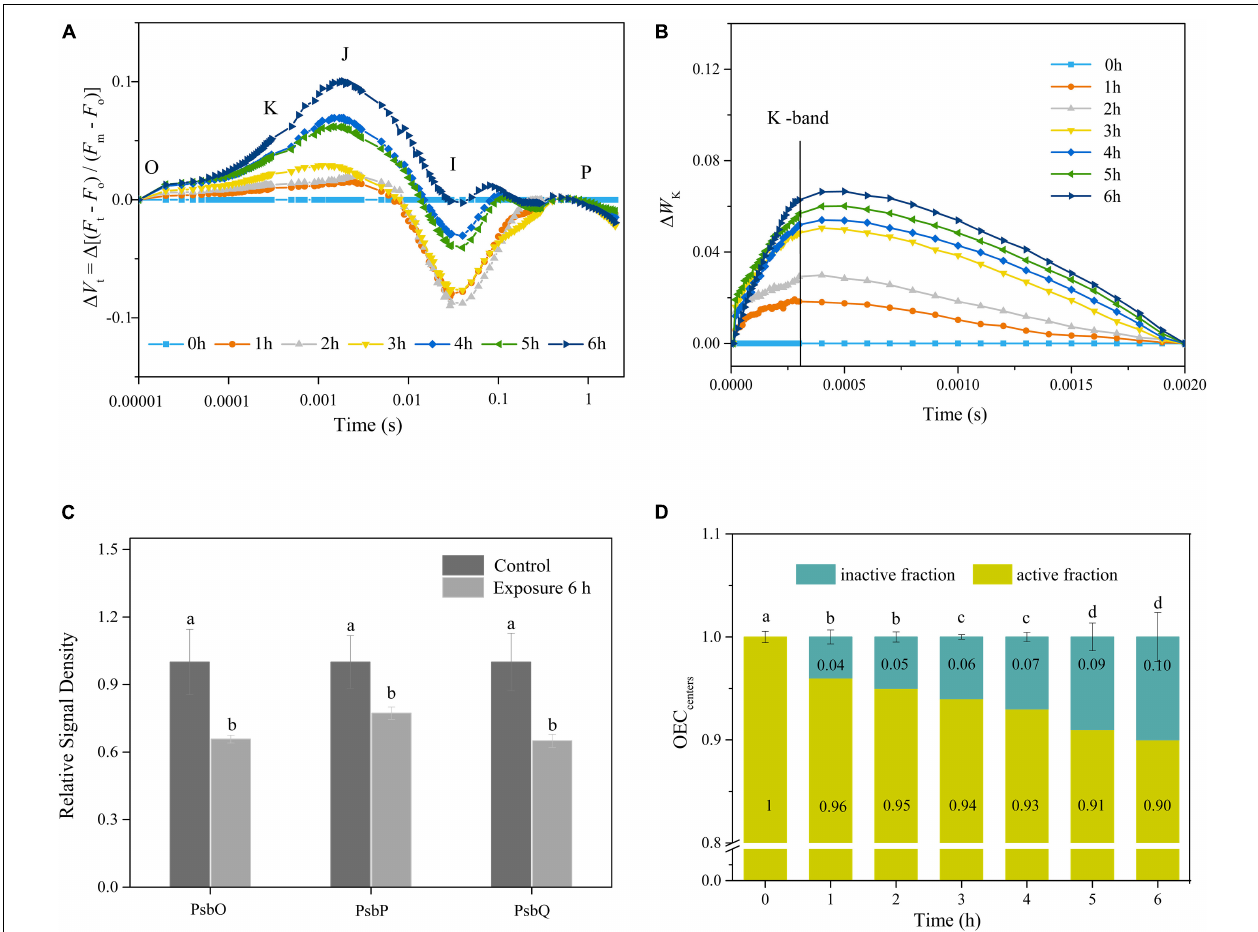
FIGURE 2 | (A,B) Time courses of normalized chlorophyll a fluorescence intensity of (cid:49) V t and (cid:49) W K curves in response to HL (400 µ mol photons/m 2 s) exposure. Each curve represents the average of three replicates. (C) The relative expression levels of OEC peripheral proteins after 6 h HL exposure. The means ± SD were calculated from three independent samples. Different letters indicate a significant difference (Tukey’s tests, p < 0.05). (D) Variations in OEC centers in response to HL exposure. The means ± SD were calculated from three independent samples. Different letters indicate a significant difference (Tukey’s tests, p <